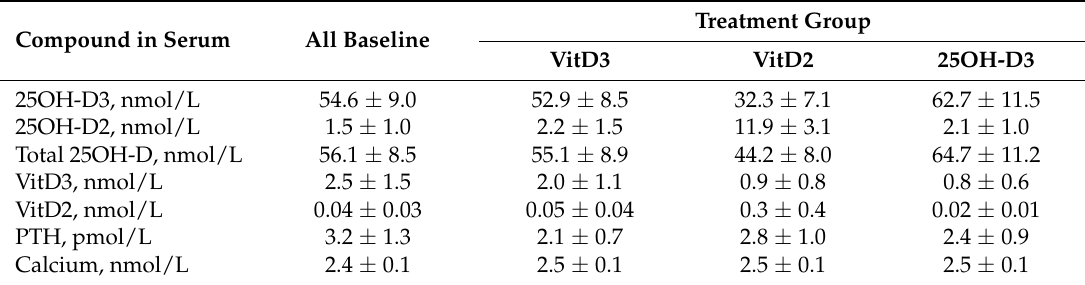
Table 3. Estimated level of vitamin D based on the model including the factors treatment and period, the covariate the baseline value and a random effect of